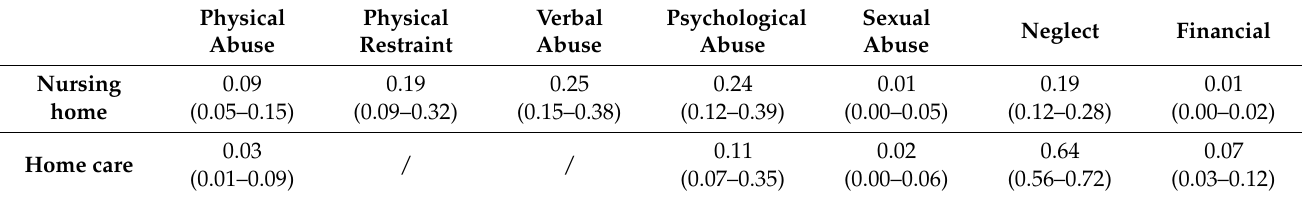
Table 2. HCWs’ self-reported violence in different LTC settings.